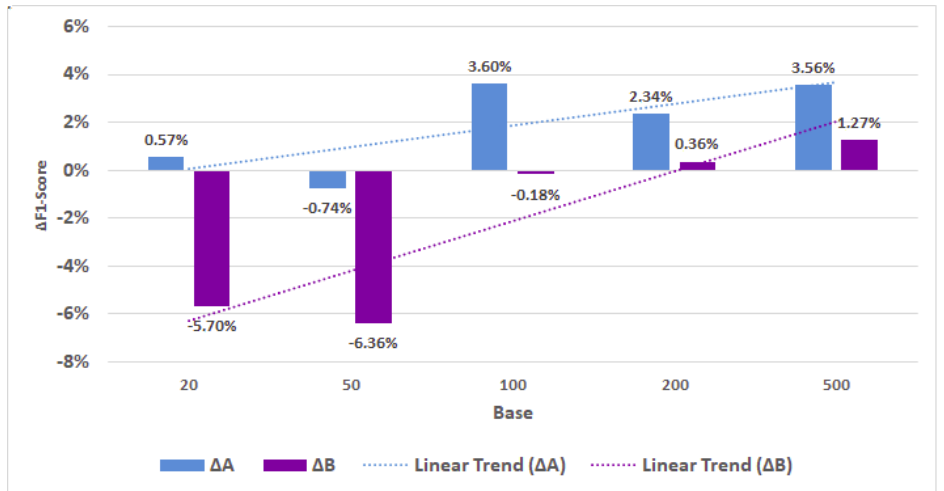
Figure 5. F 1 score performances at 1:1 positive negative ratio dataset, Alpha 0.1, and Random Deletion